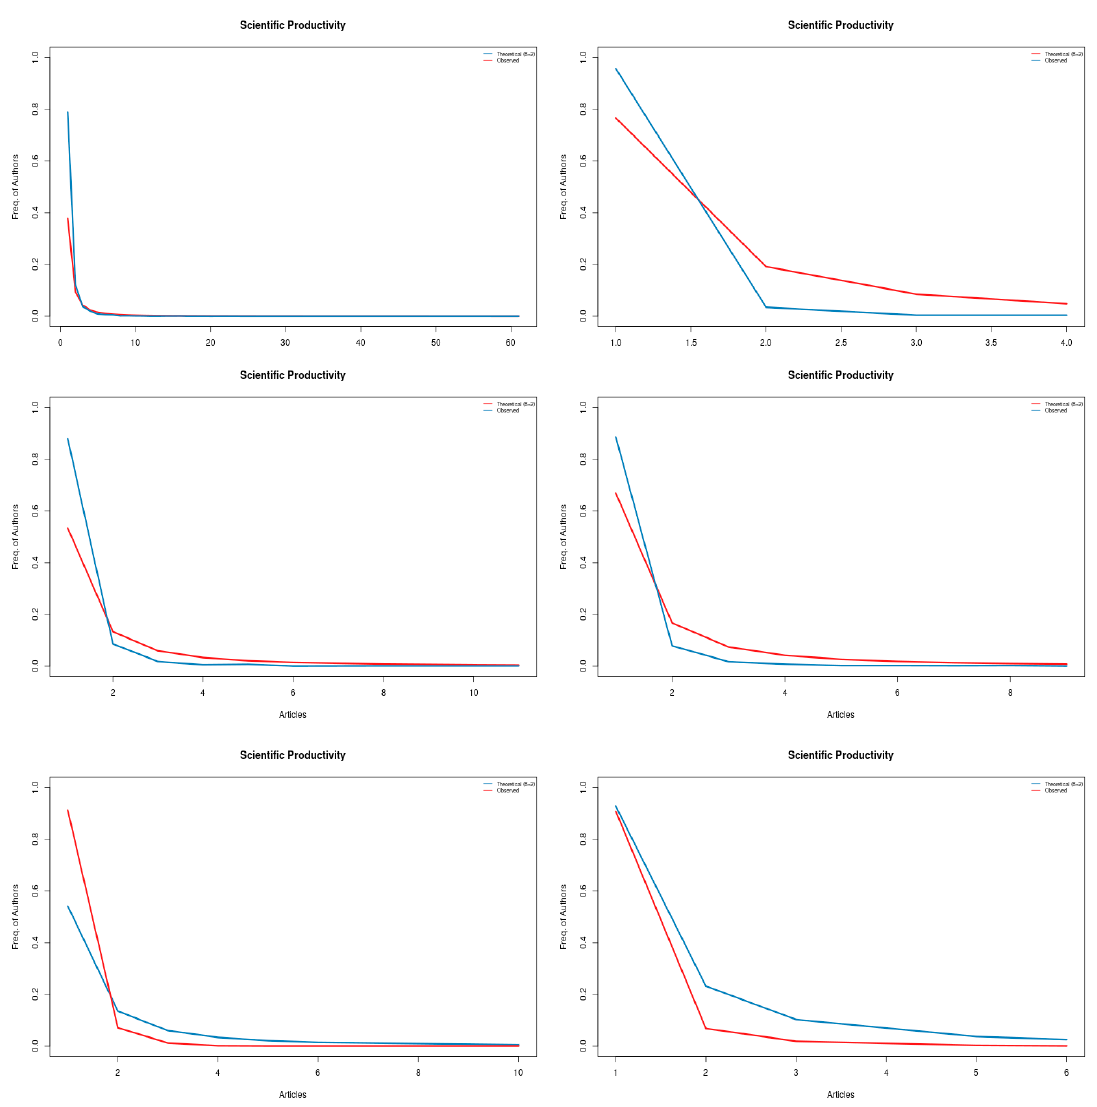
Figure 6. Scientific productivity, overall period, and per year.